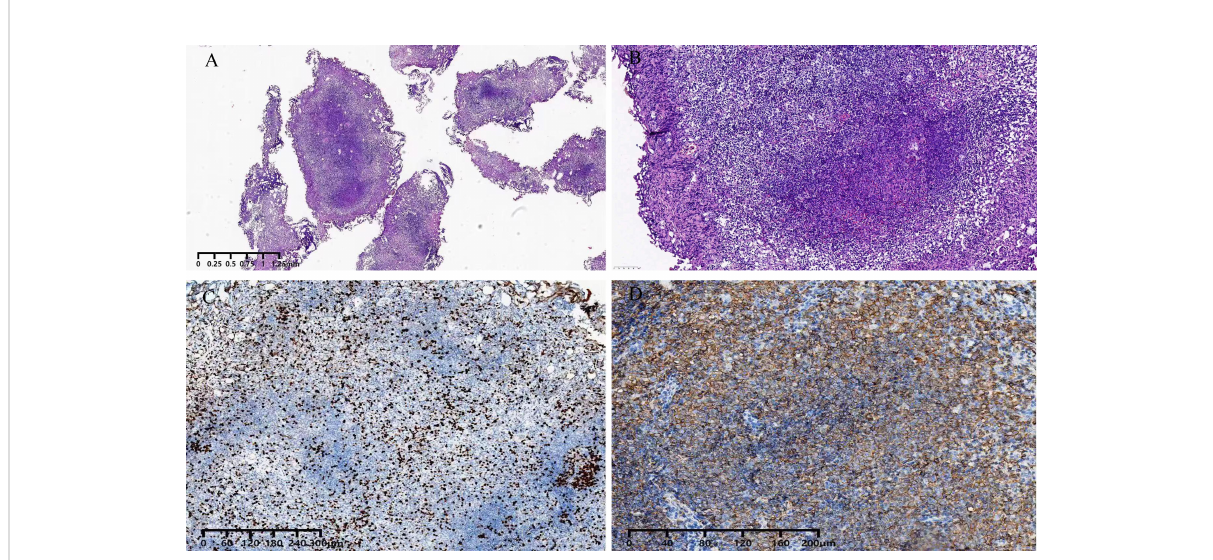
FIGURE 4 Pathology. Hematoxylin-eosin staining of a surgical specimen. demonstrated MALT lymphoma [ (A, B) ]; Immunohistochemical staining. demonstrated ki-67 expression (C) . Immunohistochemical staining demonstrated. CD20 expression (D)